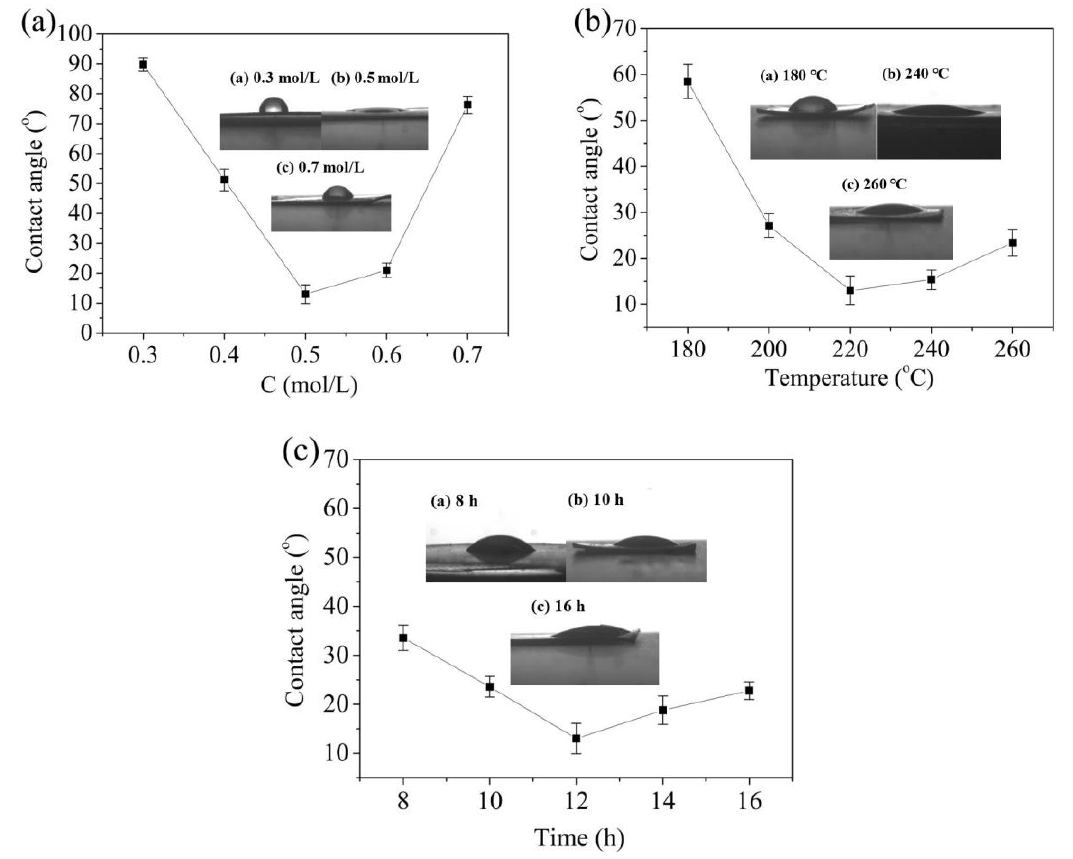
Figure 13. Hydrophilic property of TiO 2 nanorods prepared at ( a ) different concentrations of HCl; ( b ) different temperatures; ( c ) different reaction times after ultraviolet irradiation.